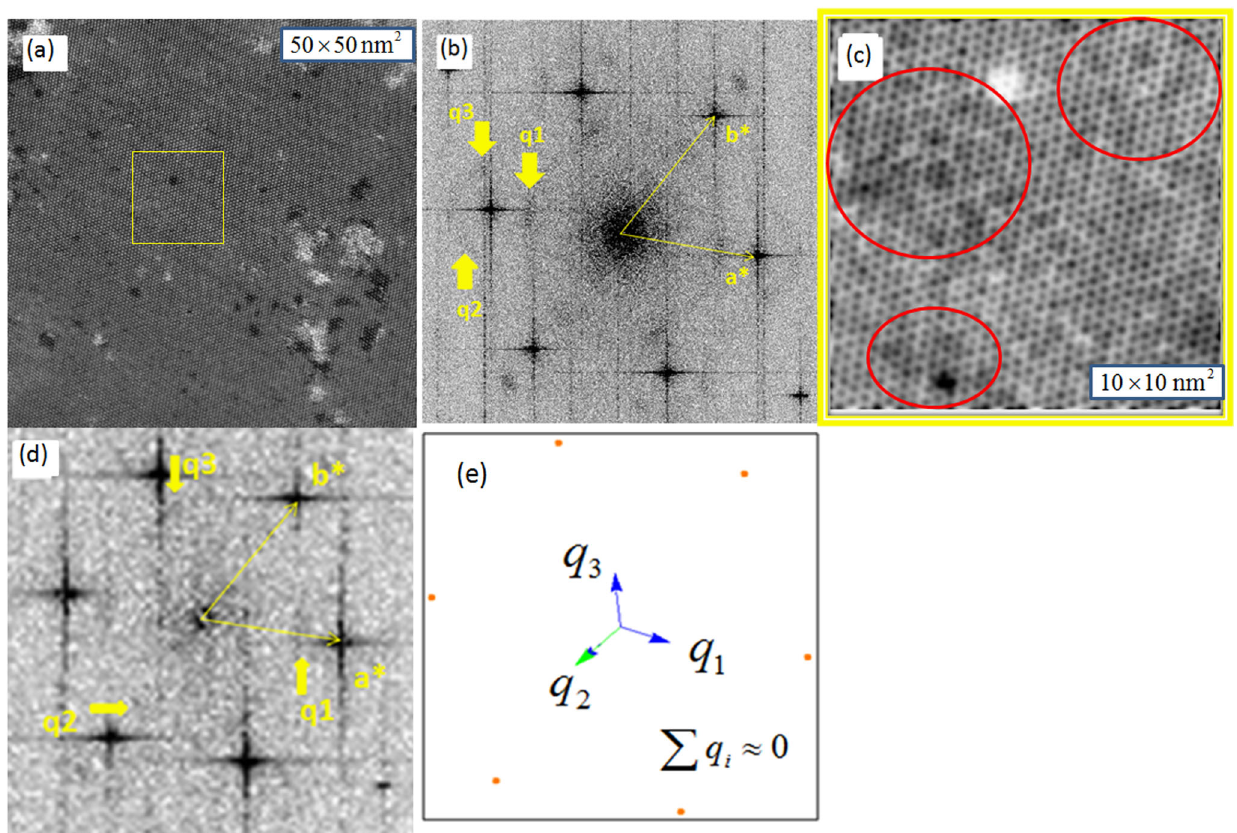
Fig. 4 Bi-layer 1T-TaS 2 a STEM image of bi-layer 1T-TaS 2 at room temperature. Super-lattices of CDW are seen through- out the entire sample and are particularly obvious in the yellow frame in the middle of this fi gure. b FTI of Fig. 4(a). The CDW satellites shown by the yellow arrows are largely diffused. c Enlarged view of the yellow frame in Fig. 4(a) with inverted contrast. The brightest circle in Fig. 4(c) corresponds to the darkest circle in Fig. 4(a). Black hexagons correspond to super-lattices. Unlike in the tri-layer sample, super-lattices do not have clear hexagonal structures in the bi-layer. Local order structures, which are shown by red circles , are present in the bi-layer. d FTI of Fig.4(c). The CDW satellites shown by the yellow arrows are largely diffused. These are similar to those shown in Fig. 4(b). e Satellite patterns of the bi-layer sample. The orange points are Bragg peaks of the lattice. The blue arrows are nesting vectors. The breen arrow is - q 1 - q 2 slightly deviates from q 3 , so the sum of q vectors is approximately